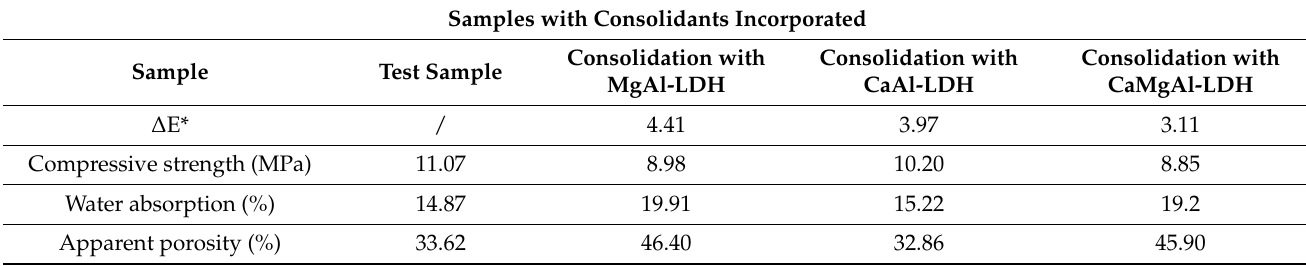
Table 6. Results of adding 5% consolidant powder into the brick composition.